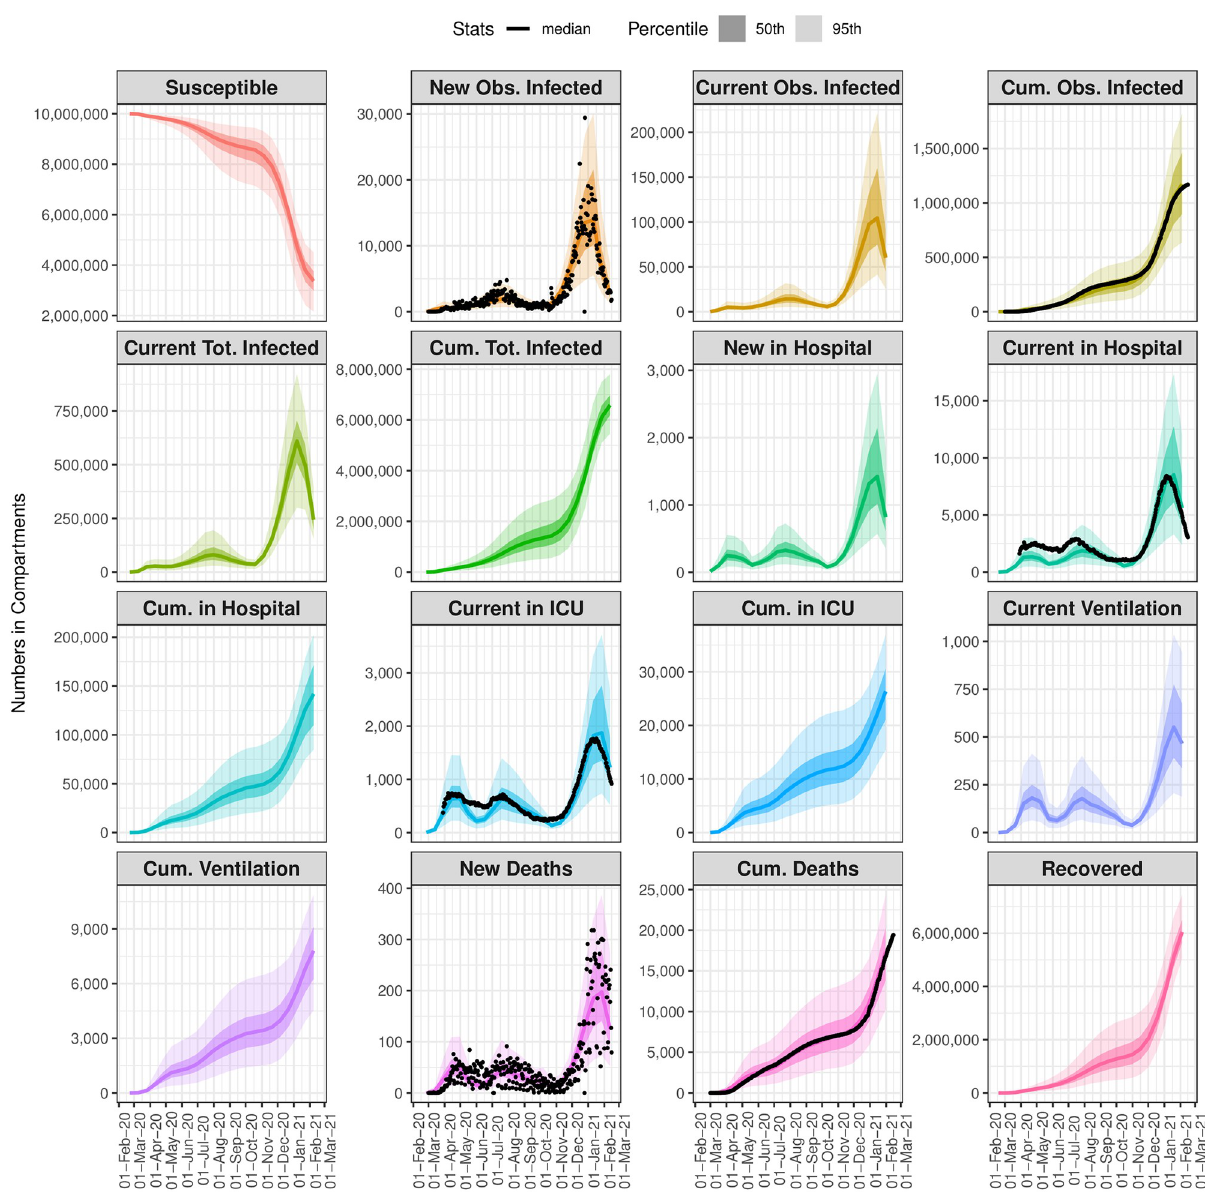
Fig 3. Summary of the epidemic model fit with COVID-19 data for Los Angeles, for all state variables, across multiple views: New cases, representing new daily incidence, current number in a compartment at a specific date, and cumulative counts. Available observed data (for new and cumulative counts)are plotted as black dots. Estimates are shown as the median number in compartments over time, with the 50% (darker) and 95% (lighter)